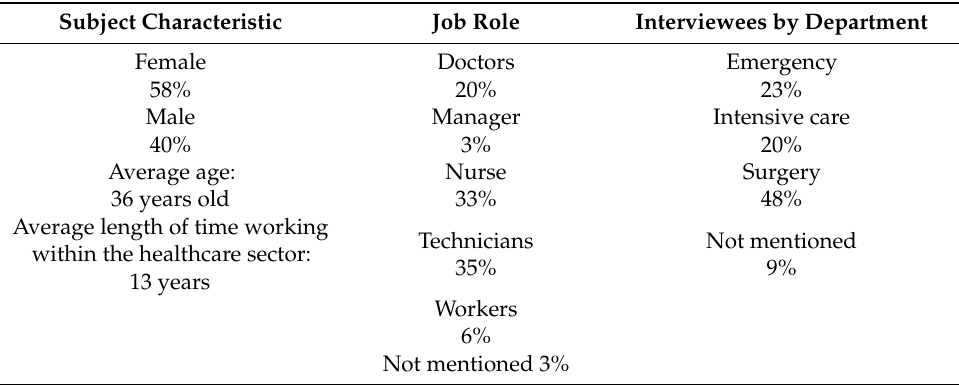
Table 2. Socio-demographic characteristics of the